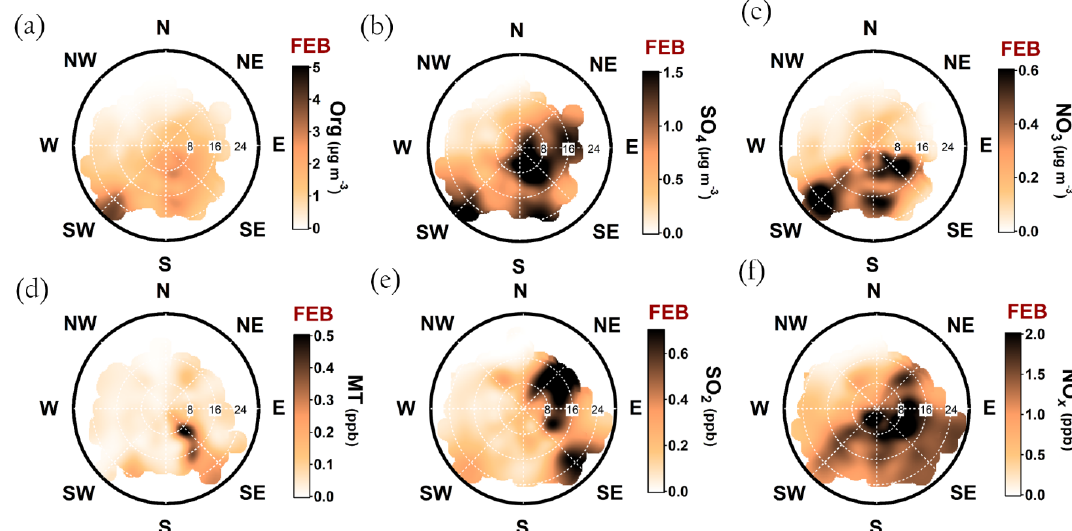
Figure A8. Openair polar plots for organic aerosol (a) , sulfate (b) , nitrate (c) , monoterpenes (d) , SO 2 (e) , and NO x (f) during February. The distance from the origin indicates wind speeds in kmh − 1 . The wind speed grid lines are presented with dashed white circles. The color scales represent the concentrations observed with each wind speed and direction combinations. As the figures do not indicate any likelihood of the wind speed and distance combinations, Fig. A1 is important to keep in mind while interpreting them. Briefly, N–NE–E is the least probable wind direction, whereas S–SW–W is the most likely. Wind speeds generally stay below 20kmh − 1